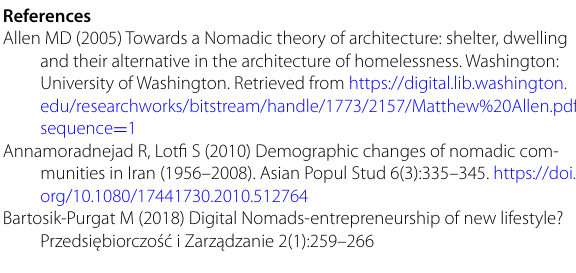
the centre of this informal architecture, the new crea- tion of space may create a distinctive identity. A better network and greater relationships may be constructed globally, reflected on a virtual mental map, as connectiv- ity and integration should be implemented digitally and globally.